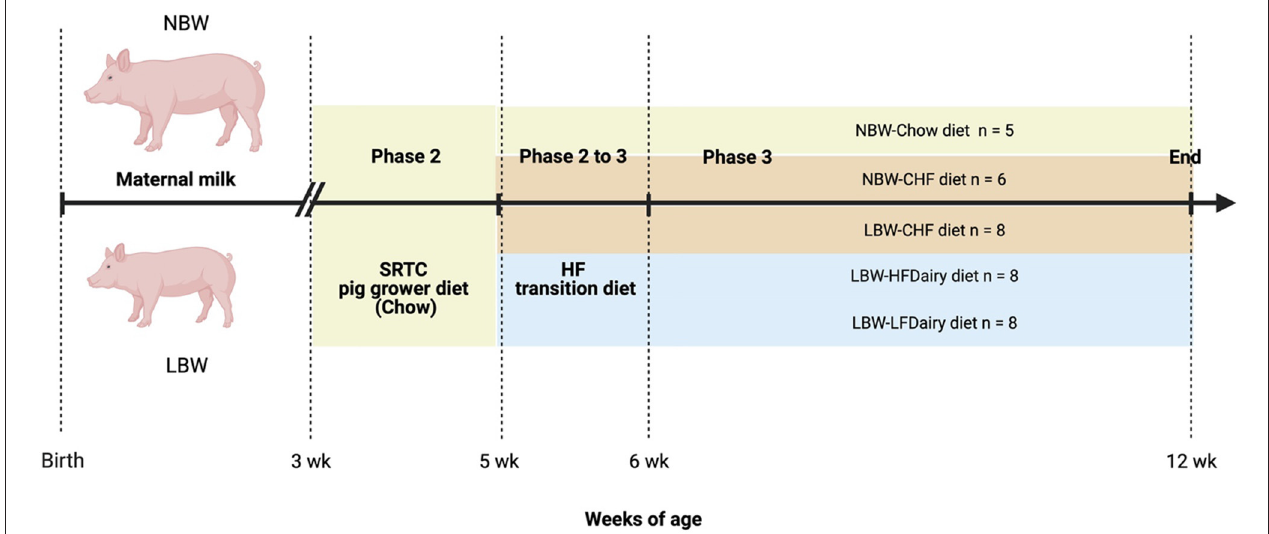
FIGURE 1 | Study design to investigate the effects of consuming dairy fats on cardiometabolic risks and immune function in swine model of IR (figure created with BioRender). CHF, control high-fat diet; HF, high-fat; HFDairy, high-fat dairy diet; LBW, low birthweight; LFDairy, low-fat dairy diet; NBW, normal birthweight; SRTC, swine research technology